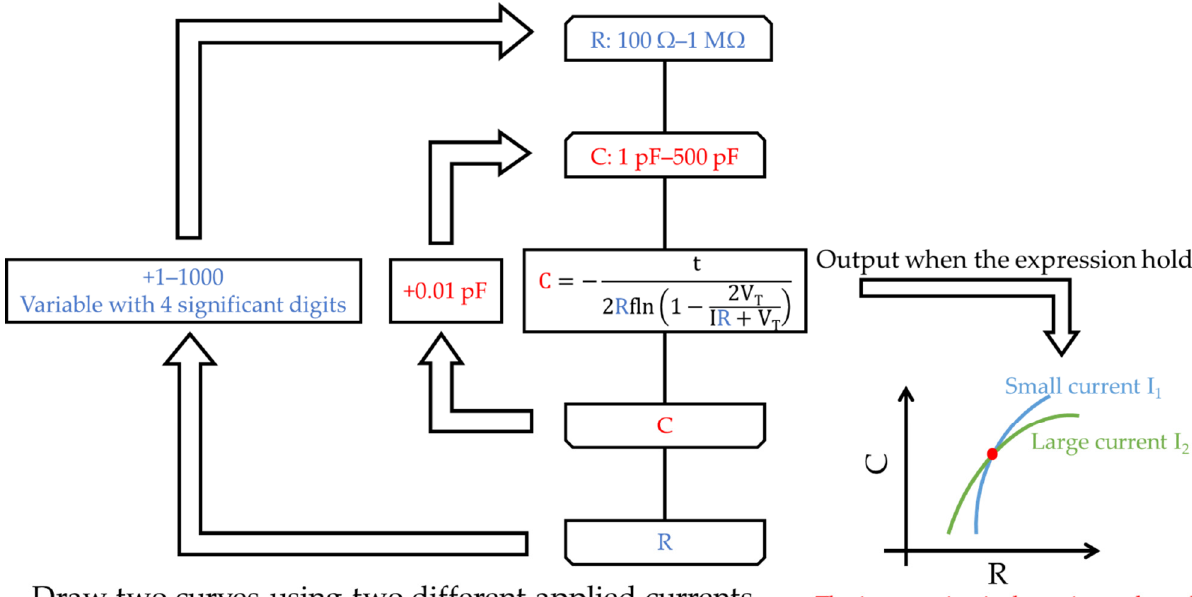
Figure 11. Flowchart of the RC calculation algorithm.